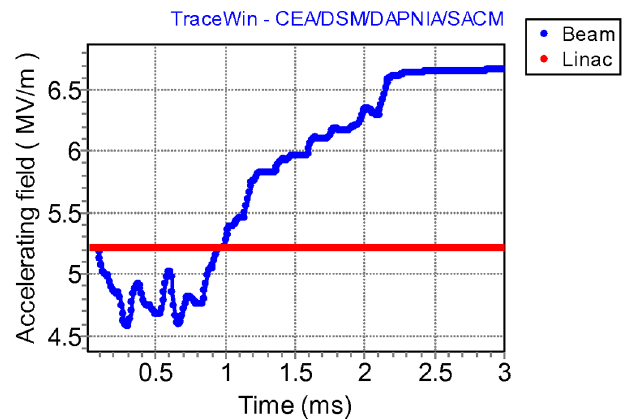
(cid:2) T (cid:2) 1 2